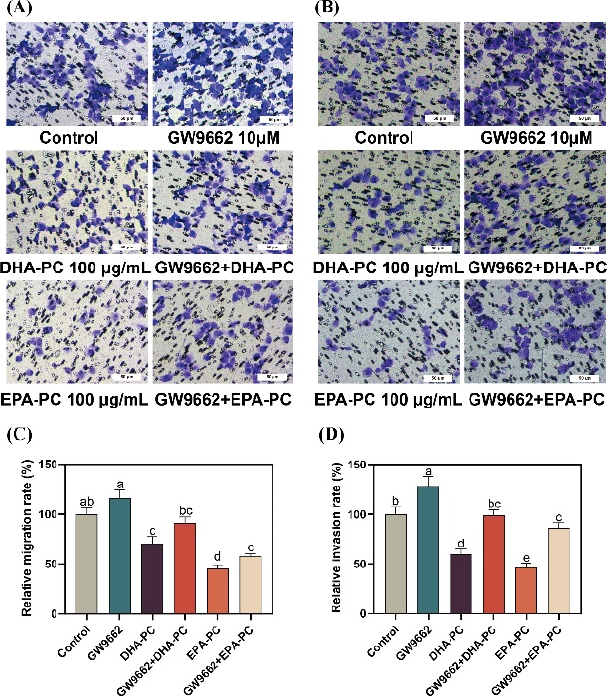
Figure 8. PPAR γ -specific antagonist reversed the effects of regarding the suppression of 95D cell migration and invasion by DHA-PC and EPA-PC. ( A ) The migrated cells were photographed under the microscope (Scale bar: 50 µ m). ( B ) The invaded cells were photographed under the microscope (Scale bar: 50 µ m). ( C ) Quantitative analysis of migrating cells. ( D ) Quantitative analysis of invaded cells. Different letters (a, b, c, d, and e) indicate remarkable differences at p < 0.05 among all groups determined by ANOVA (Bonferroni’s